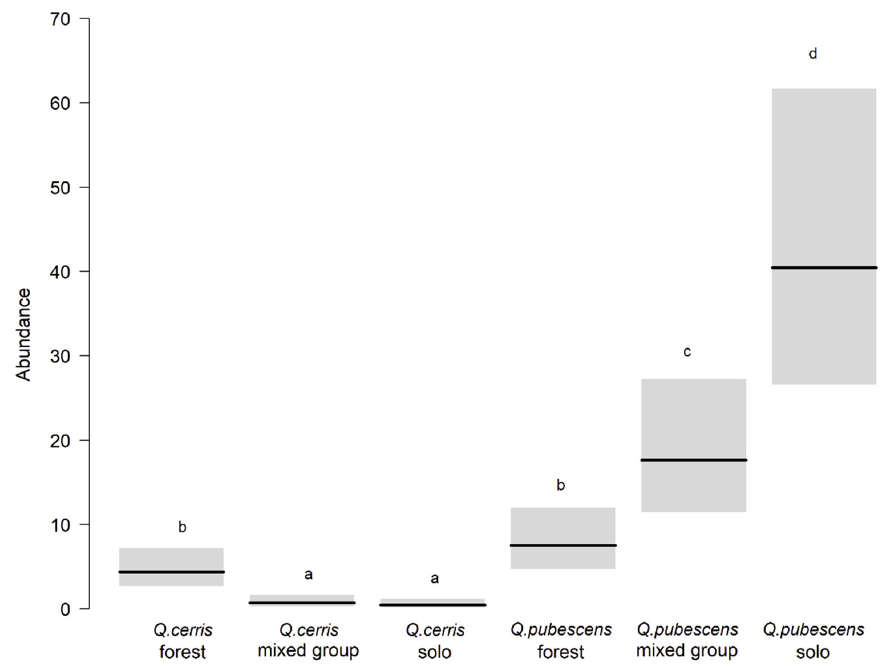
Figure 5. Abundance of Operophtera brumata caterpillars (number of individuals on three branches, each 1 m long) on mature LF Quercus cerris and EF Q. pubescens located in the forest interior (forest), and out of it, in mixed tree groups composed of Q. cerris and Q. pubescens , and on lone (solo) trees. A horizontal line denotes the mean, and bars the 95% confidence intervals. Distinct letters above columns indicate a significant difference.